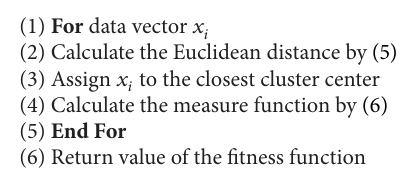
Algorithm 4: Main steps of the fitness